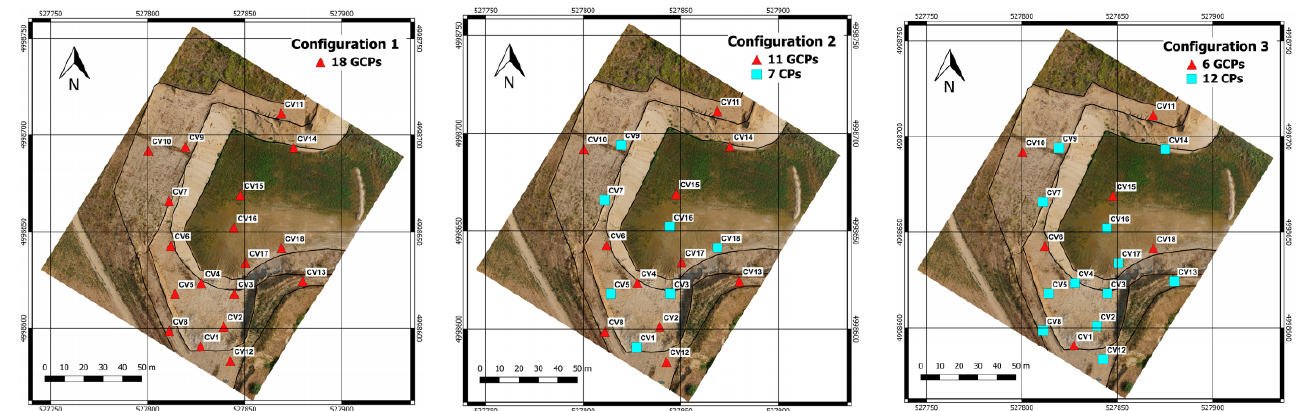
Figure 1. Configurations used to evaluate the effects of GCPs distribution and GCP vs CP relation: ( a ) is used as a control group as all the markers are used as GCPs; ( b ) illustrates the second configuration where the markers are split into two types, GCPs and CPs, where 12 markers are used as GCPs and 7 for CPs, respectively. The final image ( c ) aims to evaluate the results obtained by using less markers as GCPs. Adapted from